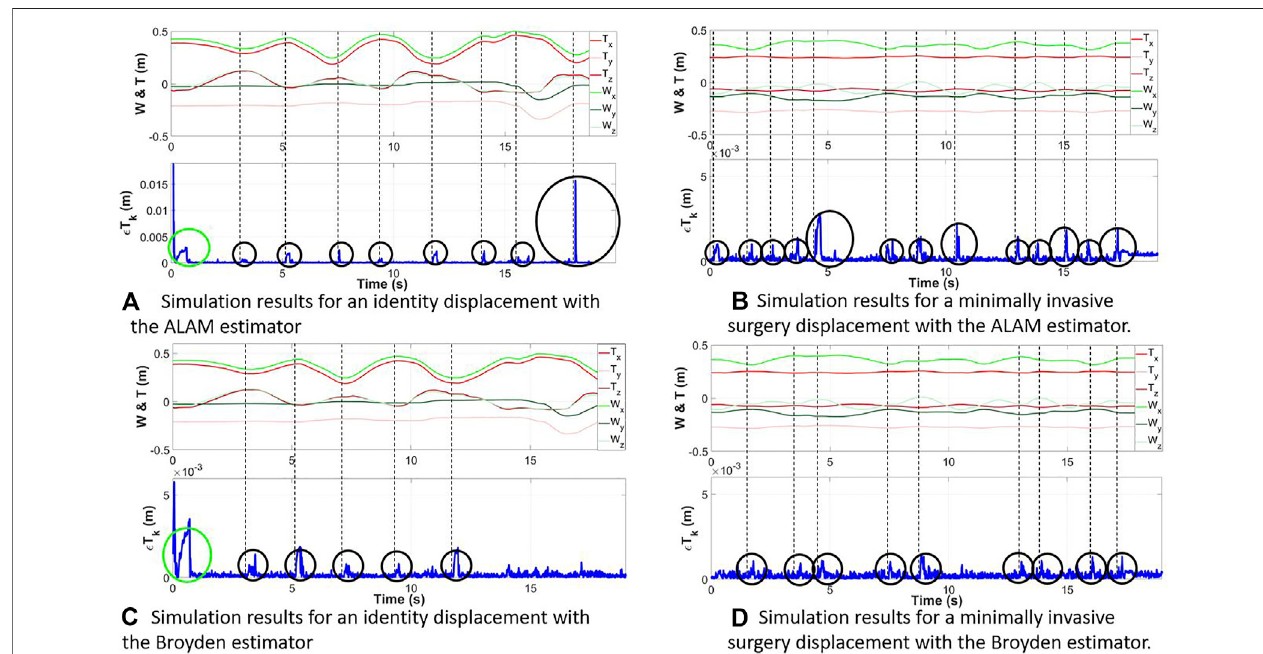
(blue)duringthe k